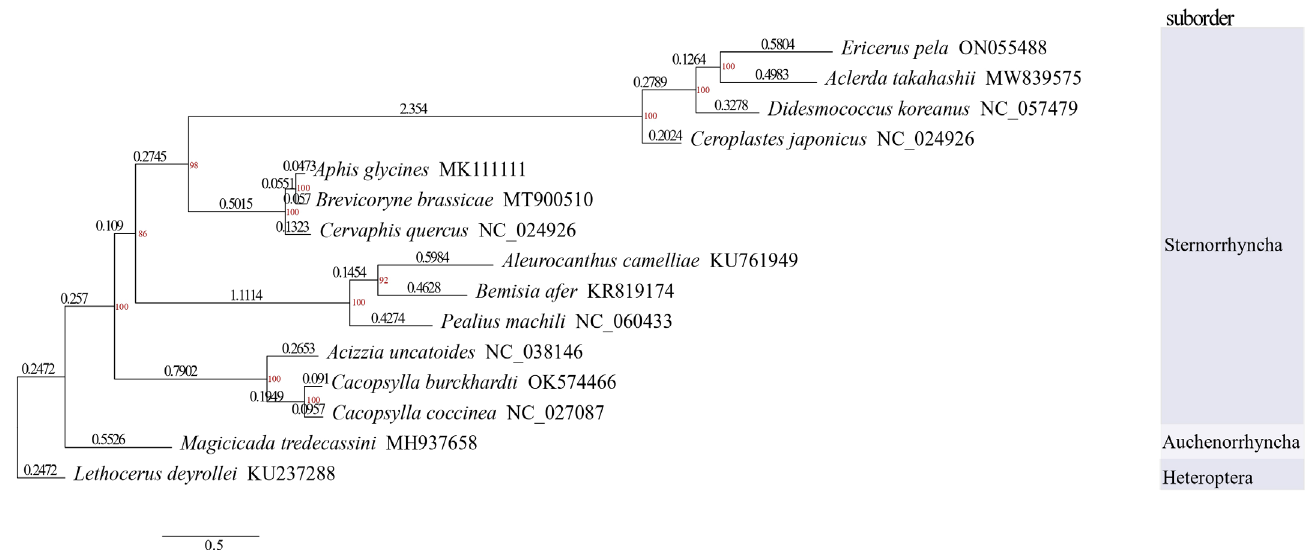
Figure 5. Phylogenetic tree based on amino acid alignments of 13 PCGs using the ML method. Bootstrap support values indicating the credibility of branches are shown on the nodes above the branches. The length of each branch represents the mitochondrial genetic variability of each species. Branch lengths are shown below the